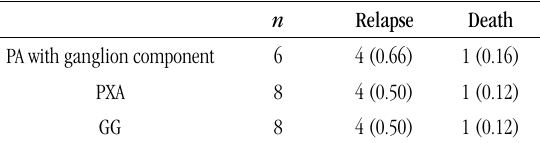
proportion for PA with ganglion component and